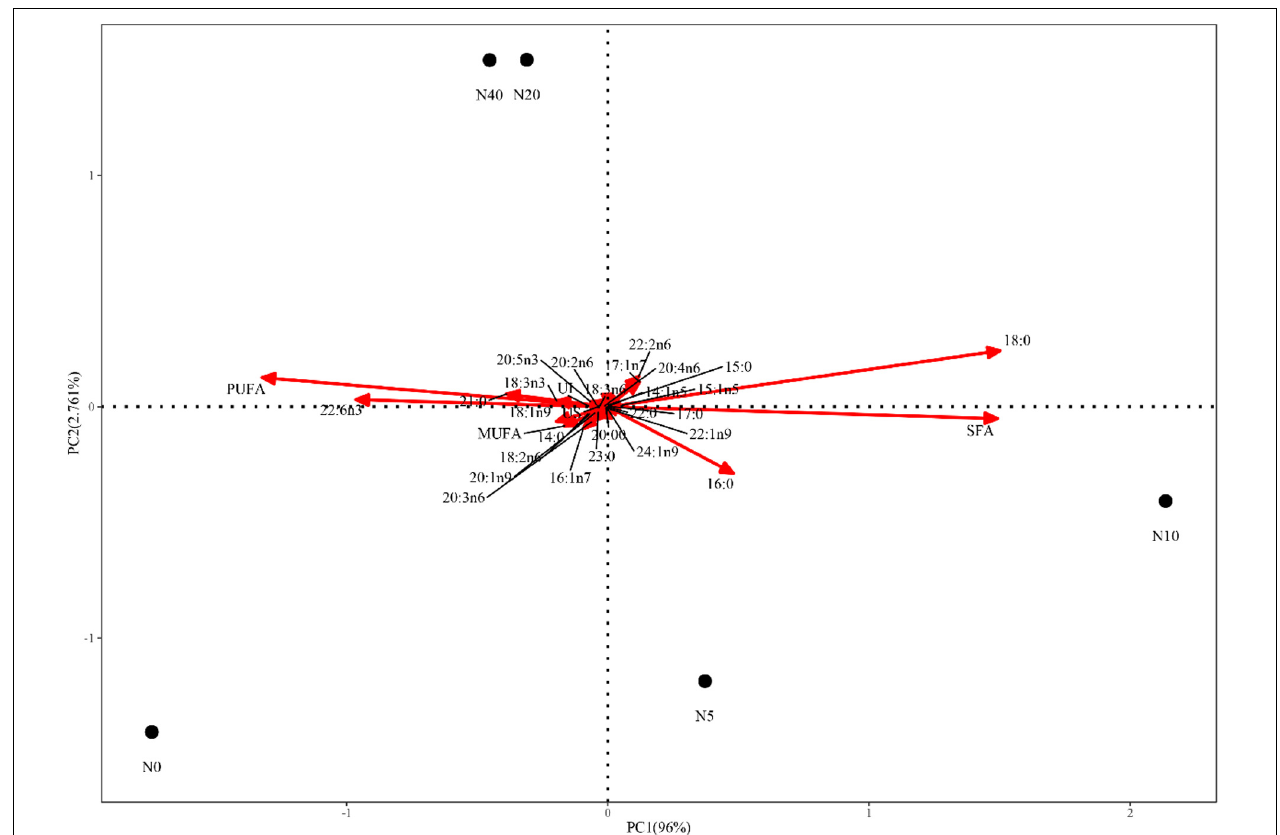
FIGURE 2 | Principal component analysis of P. damicornis larvae with different nitrate